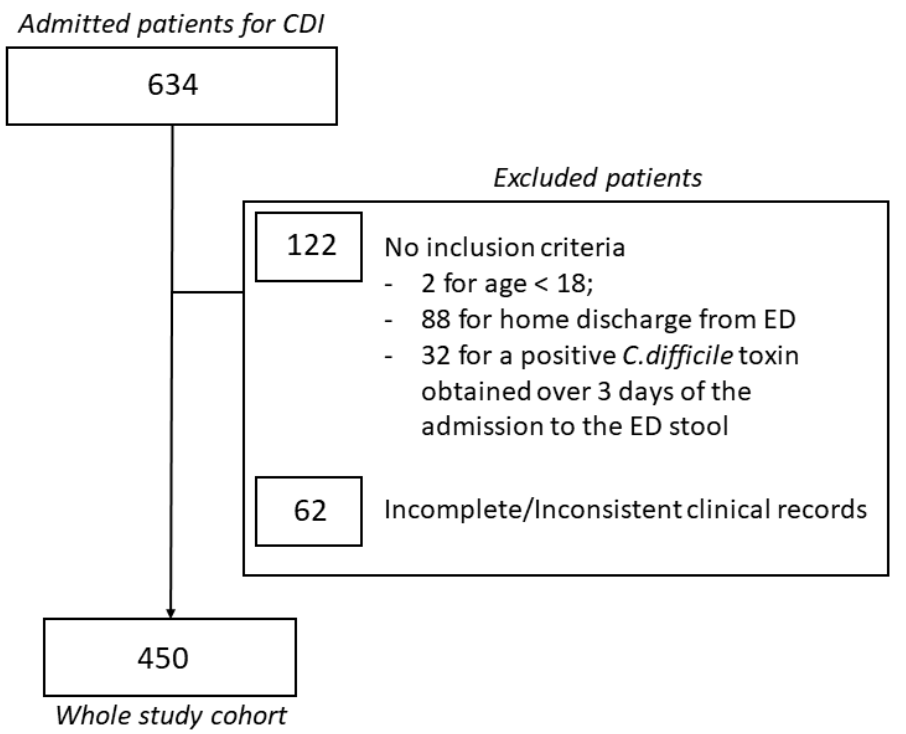
Figure 1. Enrollment process and final study population.